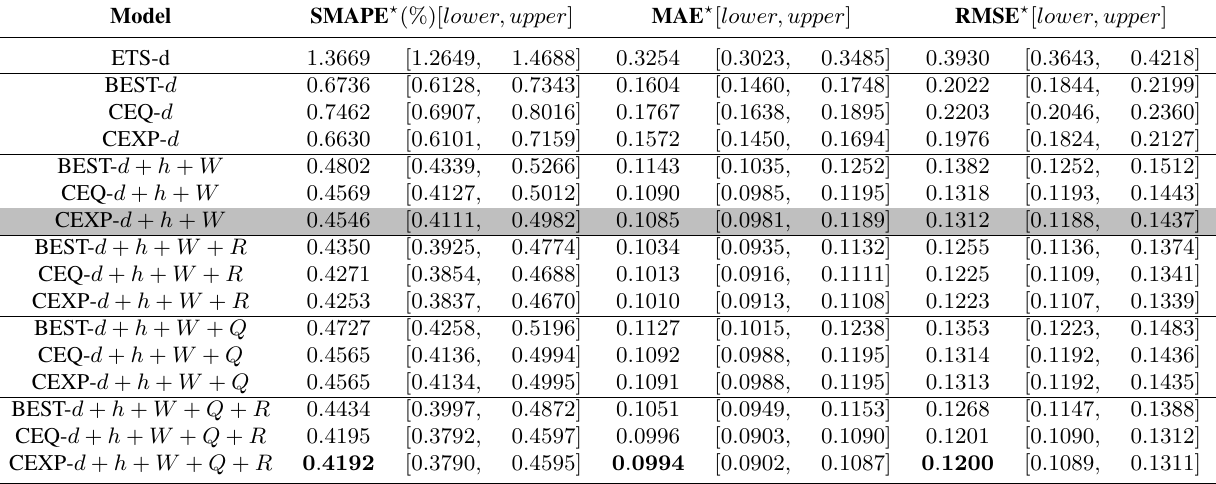
Table 5. SMAPE (cid:63) , MAE (cid:63) and RMSE (cid:63) results on test partition comparing the best models with the 99% confidence interval. Bolded face numbers are the best results, and the gray marked row is the most significant combination of covariates.